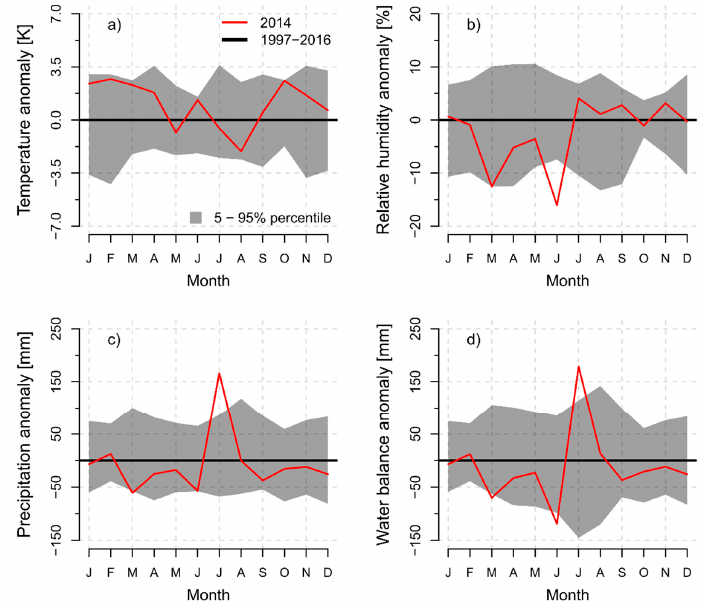
Figure 2. Monthly anomalies of ( a ) air temperature, ( b ) relative humidity, ( c ) monthly precipitation sum, and ( d ) climatic water balance (modeled according to Haude [61]) for the 450 m a.s.l. site during 2014 as a deviation from the 20-year baseline climate period of 1997–2016 (bold horizontal zero line). Shaded areas represent the 5th and 95th percentile of the annual deviations of the 20-year mean values for the baseline climate period.